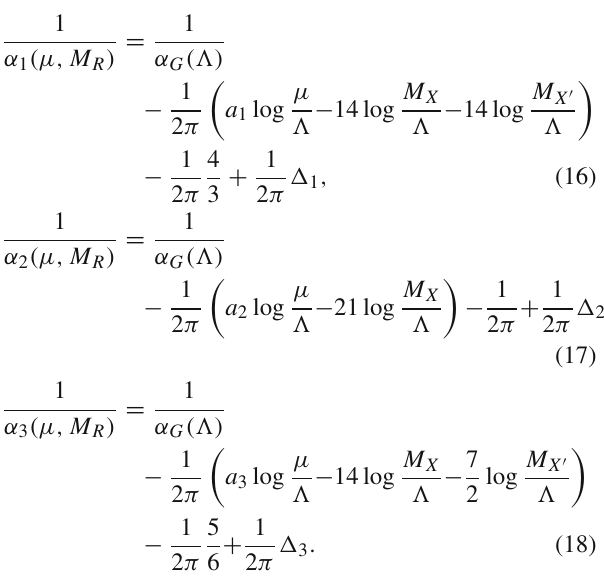
respectively. Above M R , the purple line refers to the gauge coupling of the U ( 1 ) B − L group. N E = 3 (solid), N E = 2 (dashed), N E = 2 (dashed-dotted), and N E = 0 (dotted) pairs of the extra fermion are